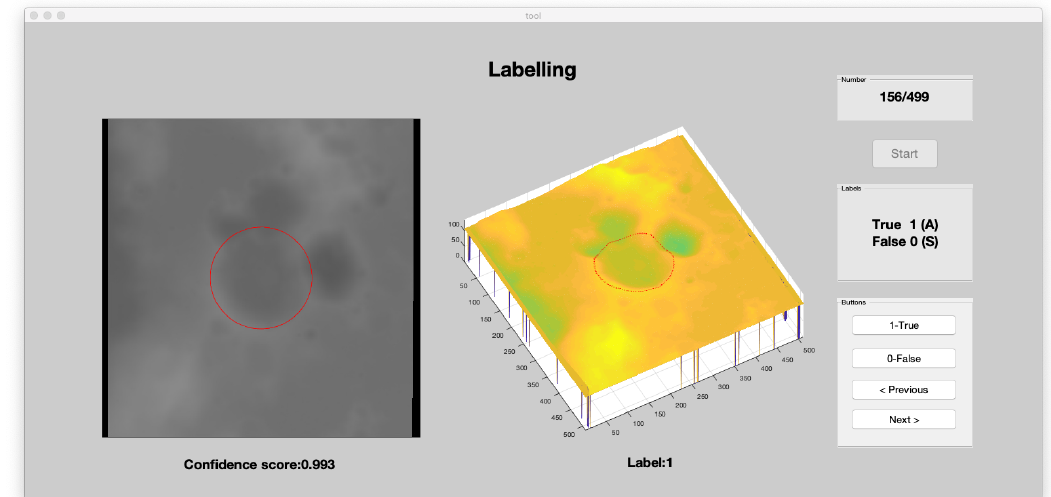
Figure 10. Graphical user interface of our crater verification